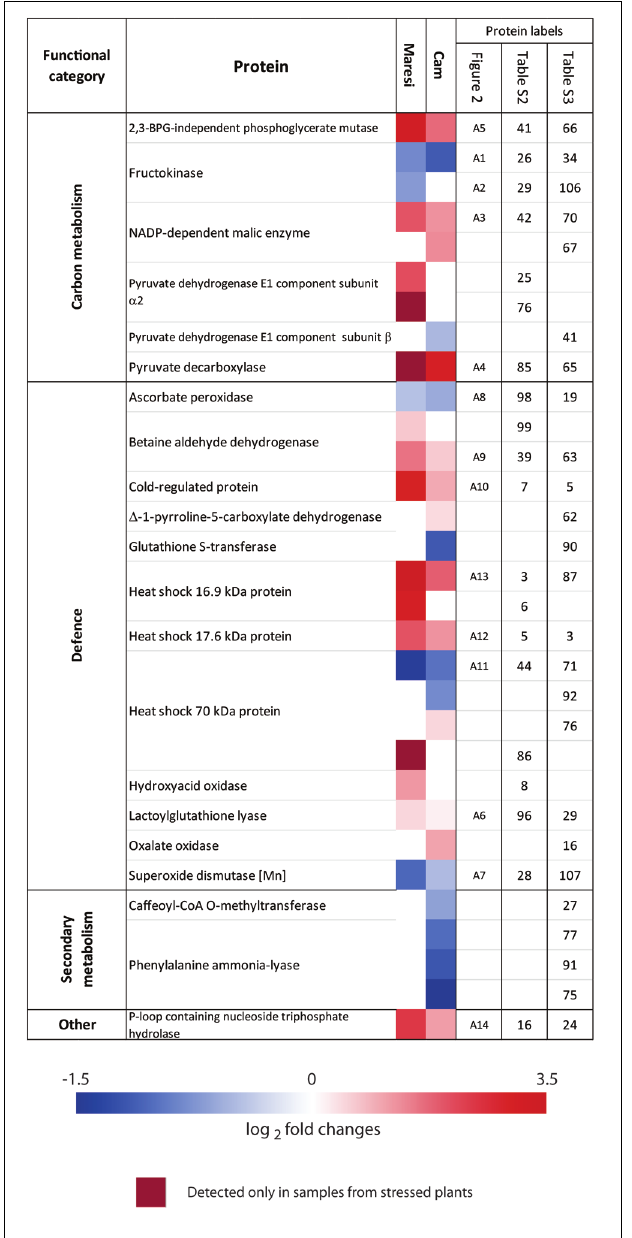
FIGURE 4 | Drought-induced changes in the accumulation levels of selected proteins identified in roots of both tested barley lines. Additional data are shown in Supplementary Tables S2 and S3.